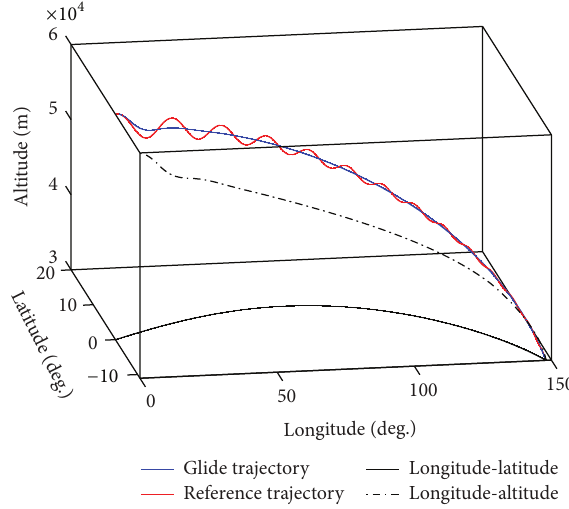
Figure 1: Three-dimensional view of